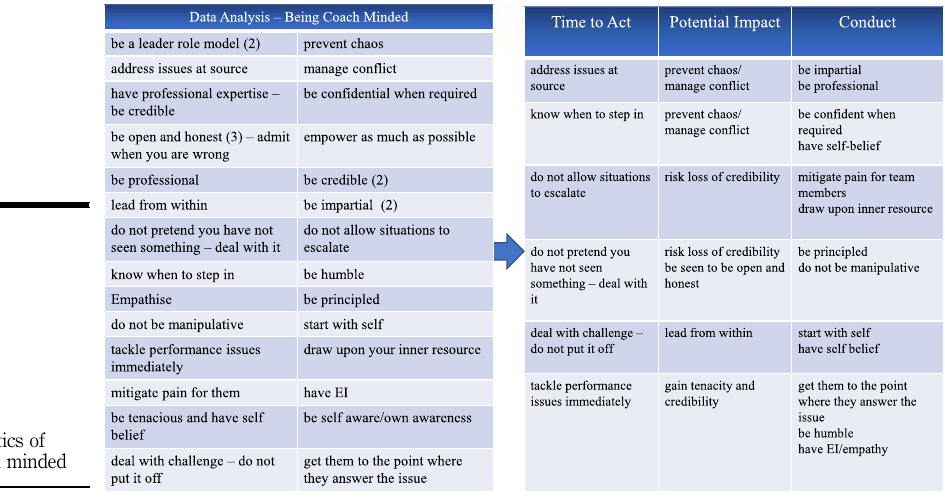
Table III. Characteristics of being coach